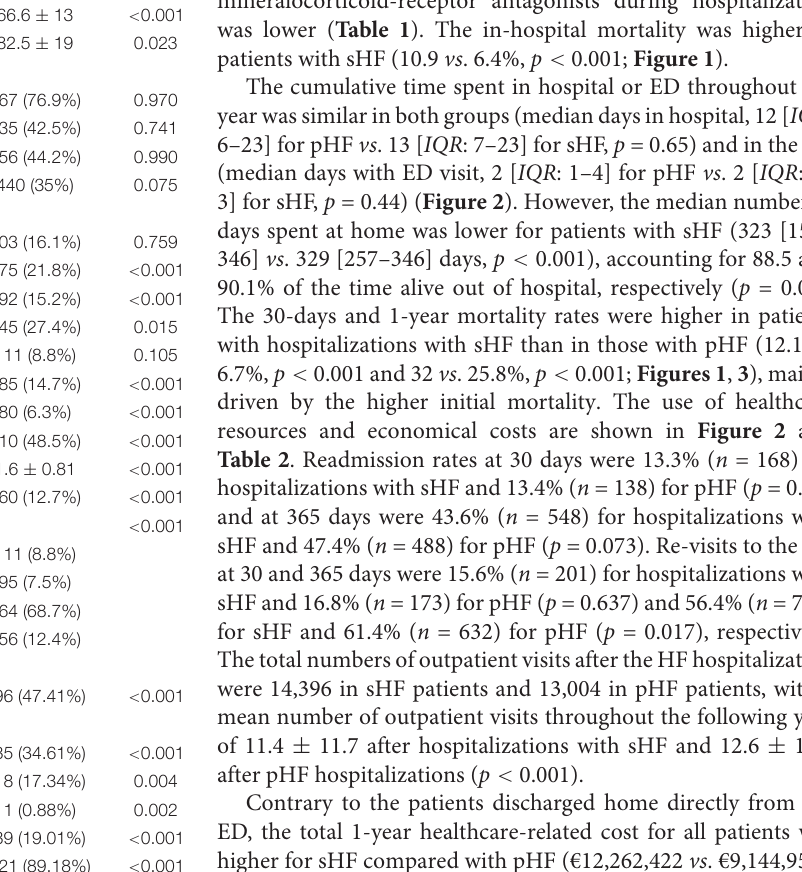
Table 2 . Readmission rates at 30 days were 13.3% ( n = 168)